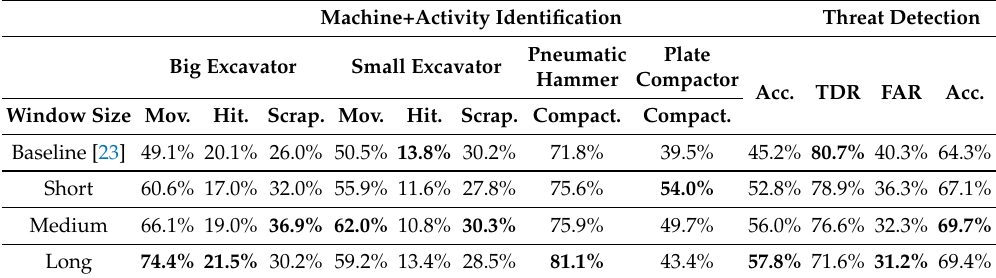
Table 4. Example of table showing classification results. Class classification accuracy and overall classification accuracy for the machine+activity identification mode, and threat detection rate (TDR), false alarm rate (FAR), and overall classification accuracy for the threat detection mode, with the best results in bold font. ‘Acc.’ stands for Accuracy, ‘Mov.’ for Moving, ‘Hit.’ for Hitting, ‘Scrap.’ for Scrapping, and ‘Compact.’ for Compacting (reproduced with permission from [24]).